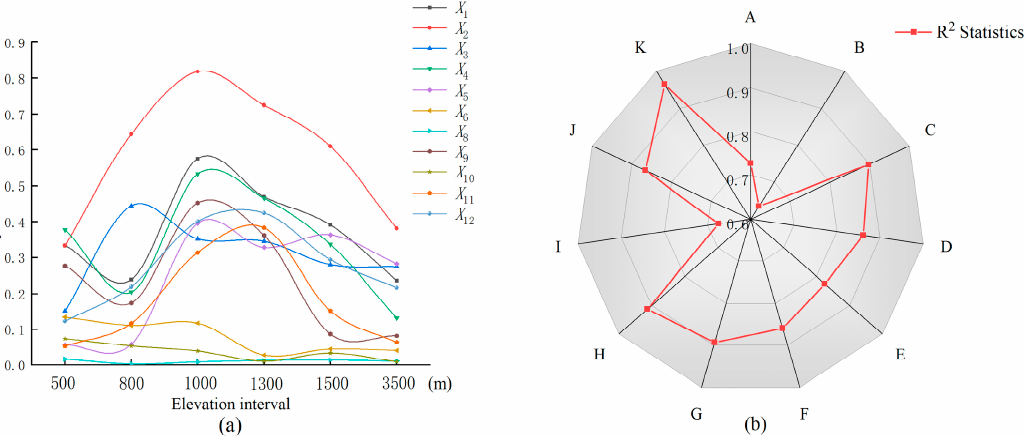
Figure 7. The change in q statistics of influencing factors on SPEI along the gradient of Elevation ( a ) and R 2 statistics of prefecture cities ( b ).